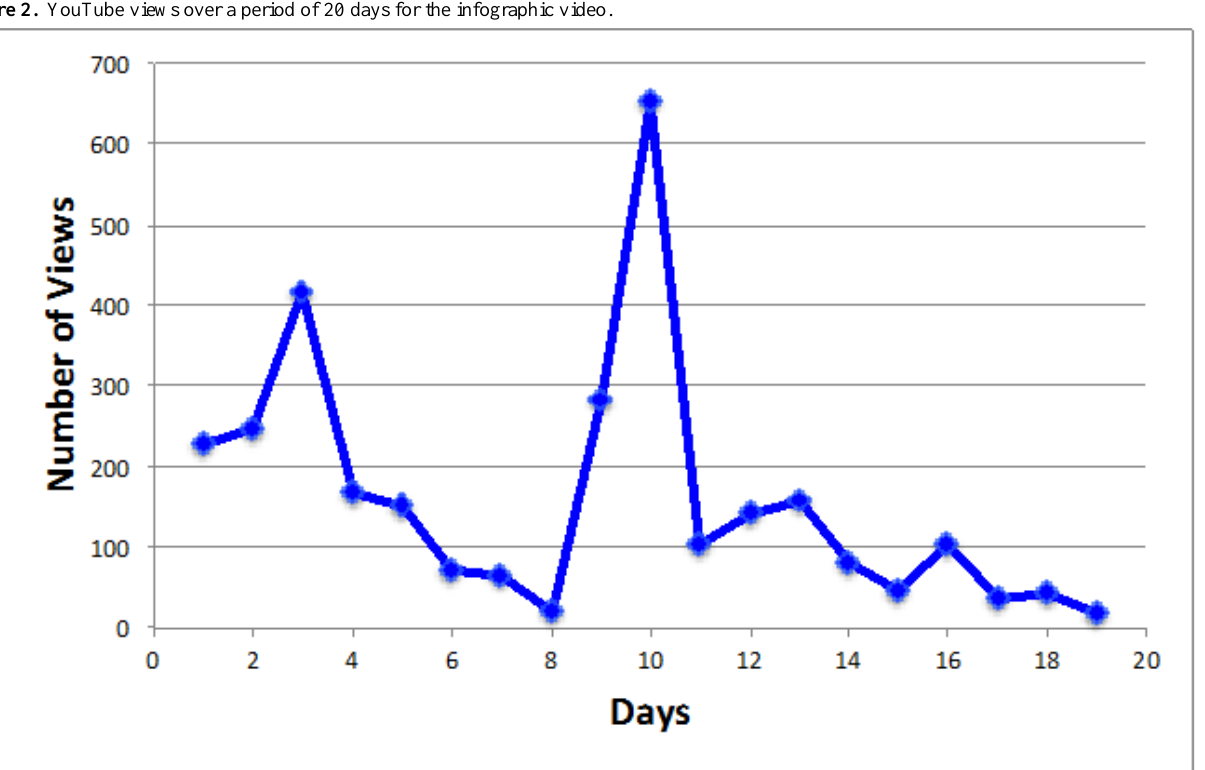
Figure 2. YouTube views over a period of 20 days for the infographic